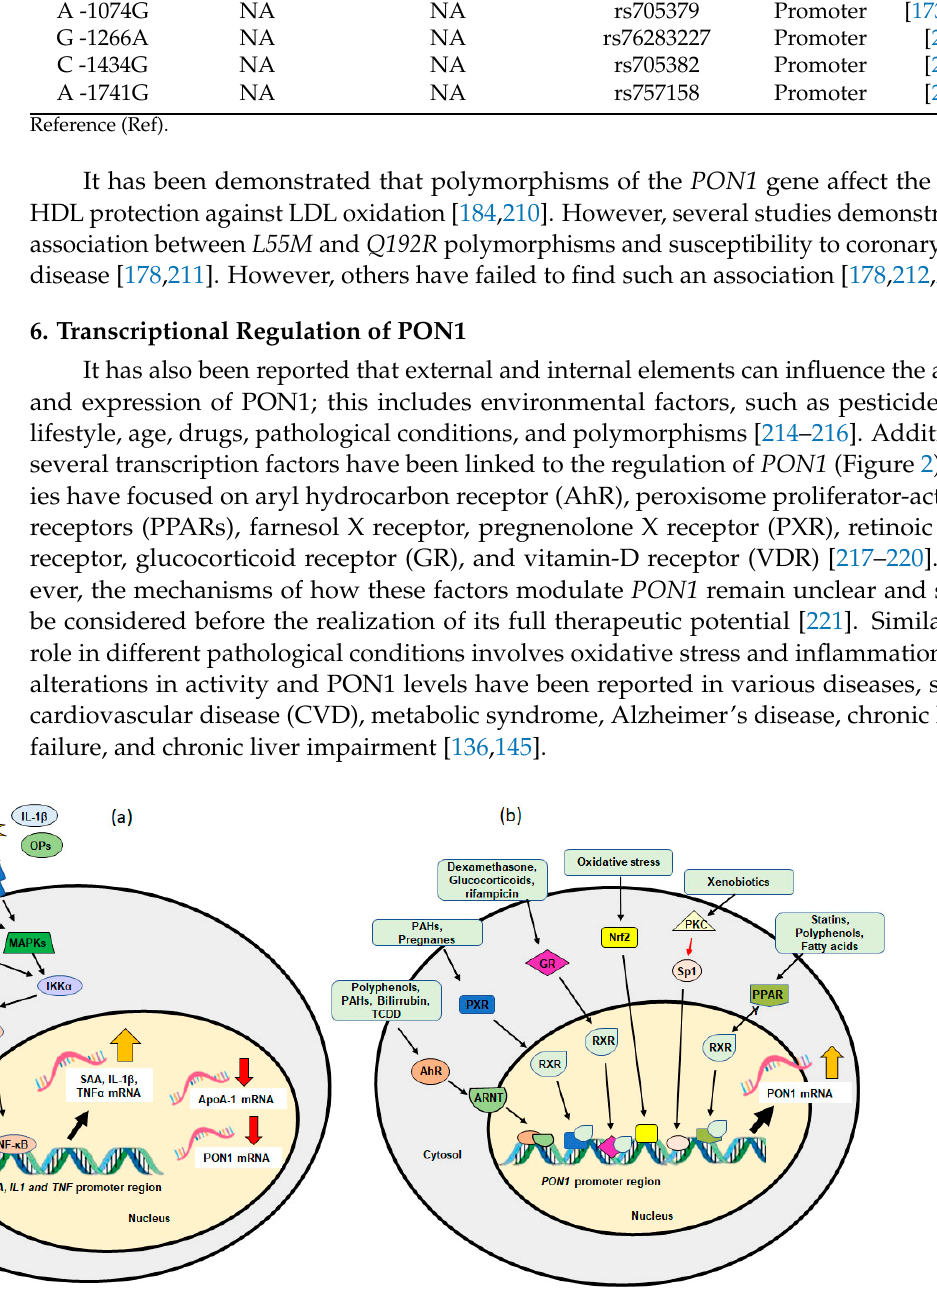
Figure 2. Mechanisms of the transcriptional regulation of PON1 . ( a ) Regulation by cytokines—the mechanism is still unclear. ( b ) Regulation through nuclear factors activated by endogenous and exogenous factors.